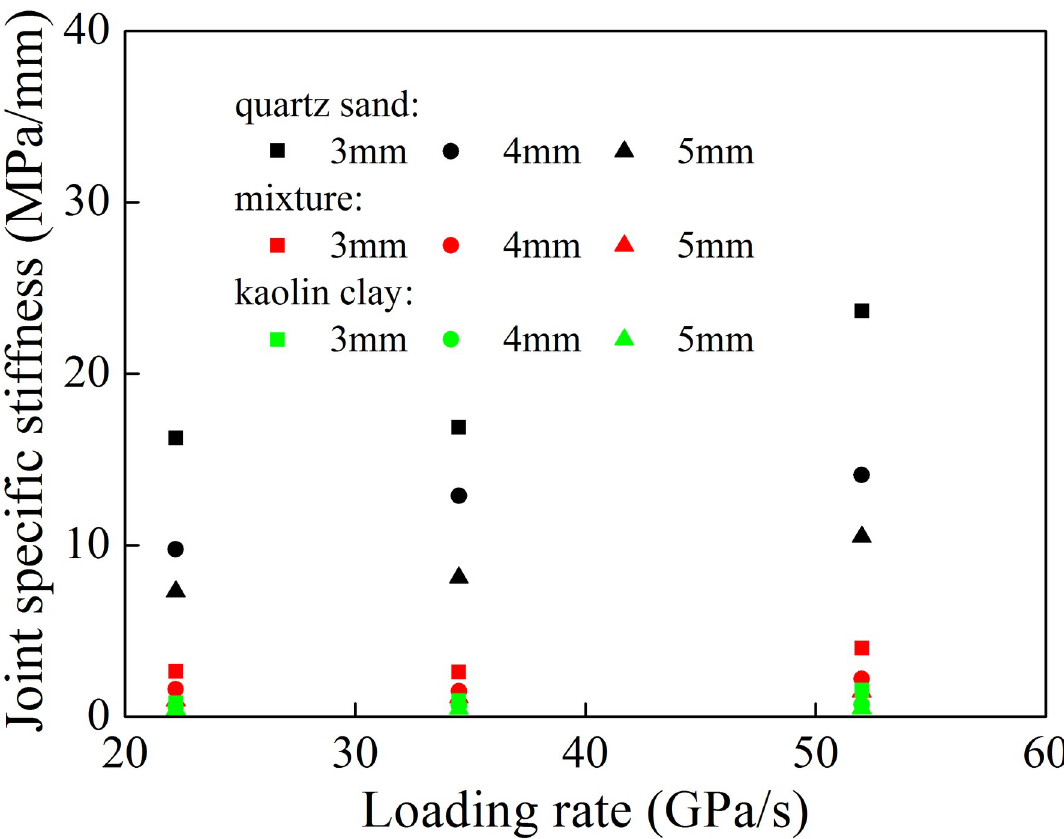
Fig 14. Variation of the joint specific stiffness with the loading